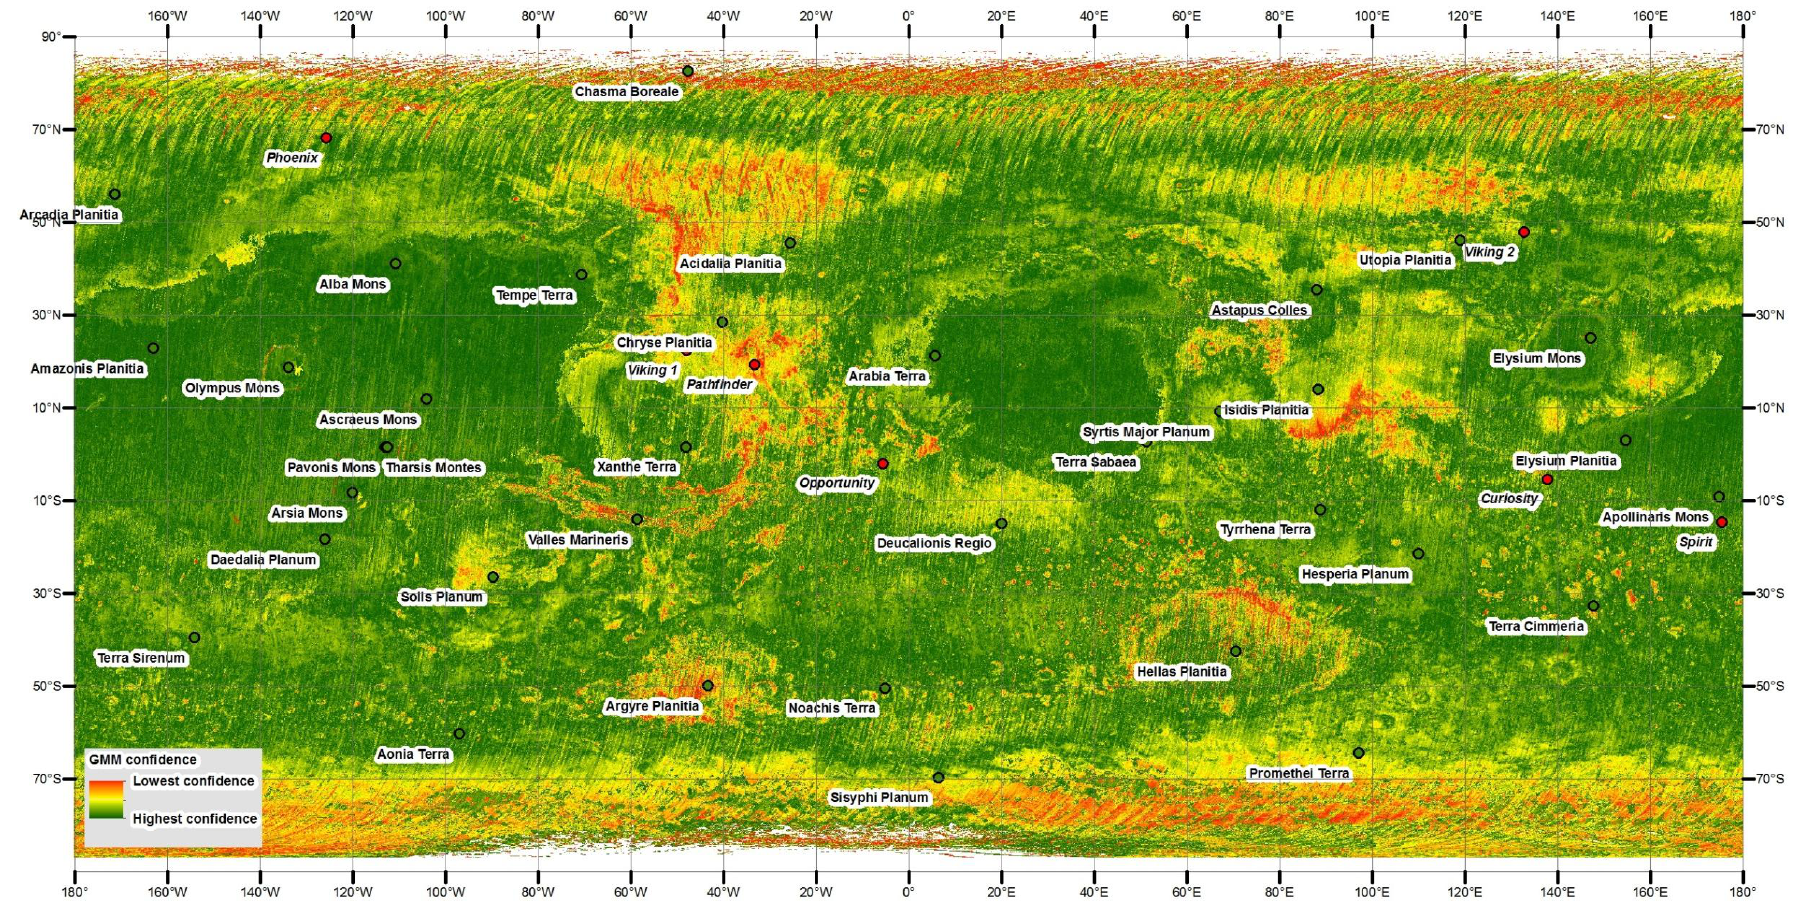
Figure 9. Global map of classification confidence based on pixel distance values from the Expectation Maximisation of a Gaussian Mixture